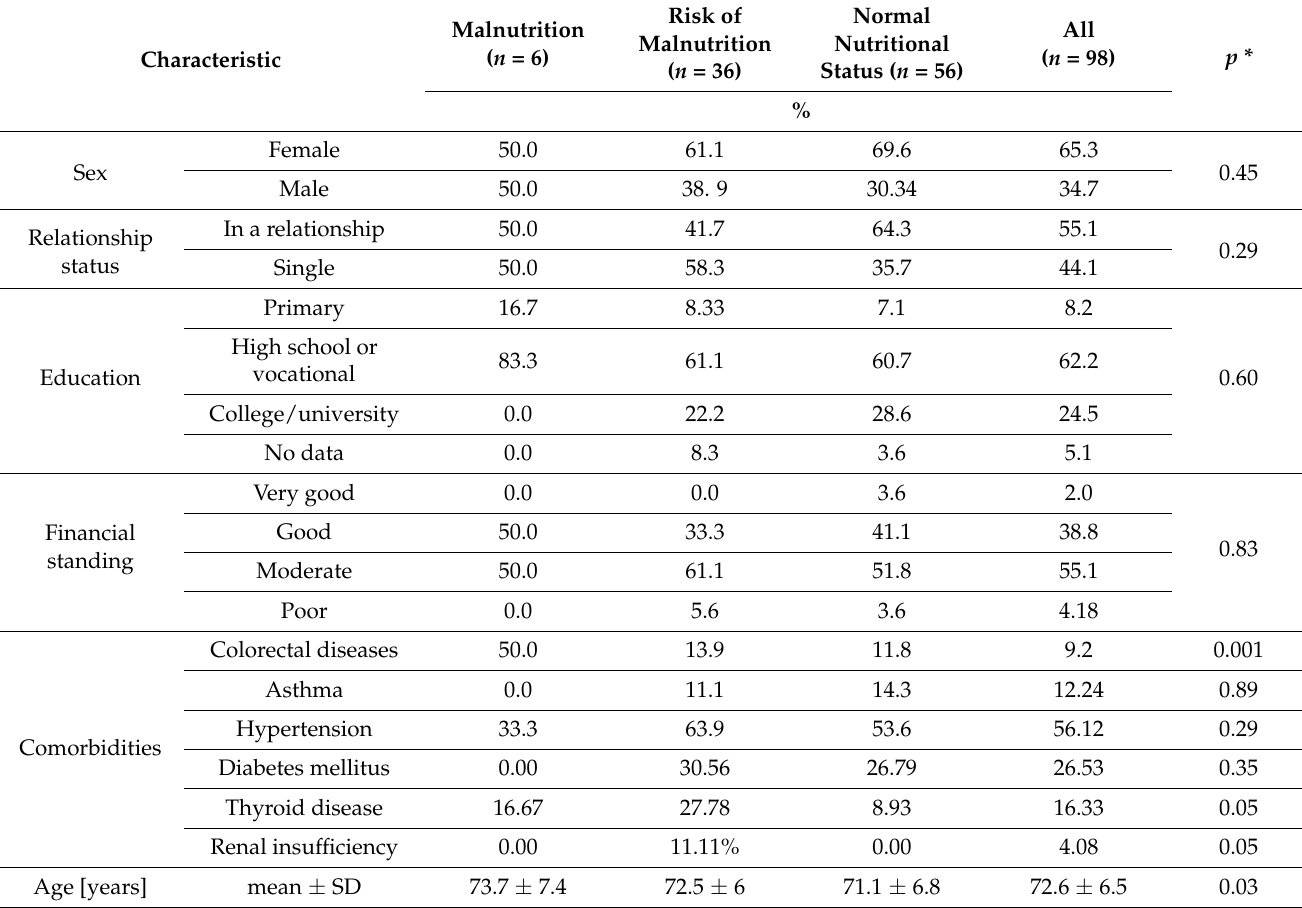
Table 1. Socio-demographic and clinical characteristics in the studied groups, by nutritional status (Fisher test).